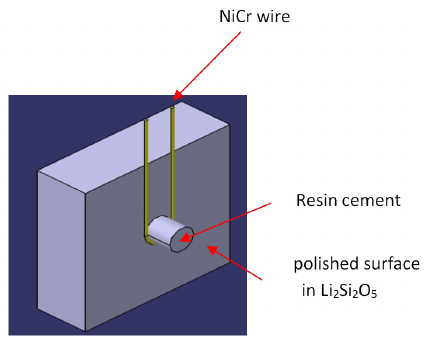
Figure 3. Schematic representation of the shear test using NiCr